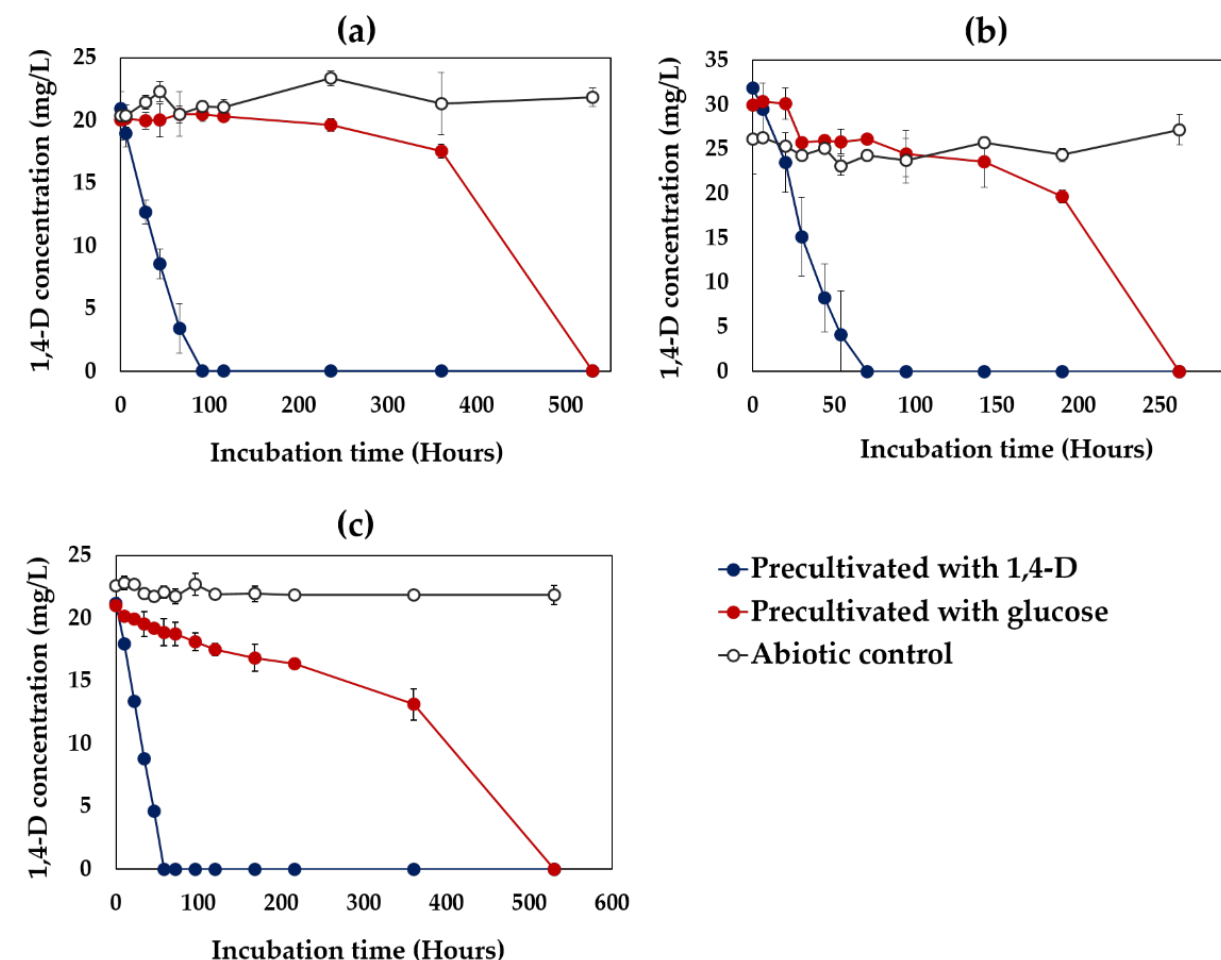
Figure 3. Inducibility of 1,4-D-degrading enzymes in the strains TS28 ( a ), TS32 ( b ), and TS43 ( c ). The initial 1,4-D and cell concentration was 20 mg/L and 394 mg-fresh cell/L, respectively. Error bars represent the MD from the duplicate experiments and may be smaller than the markers.